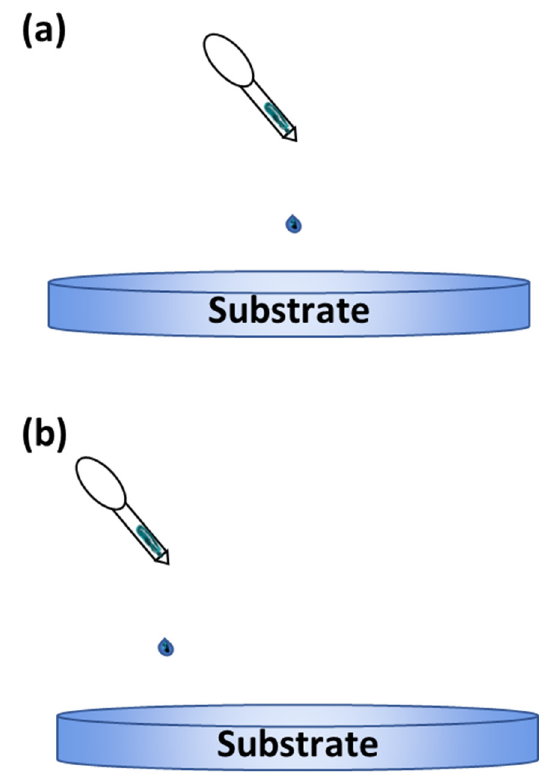
Figure 16. Illustration of the dropping positions: ( a ) central dropping; ( b ) off-centered dropping.